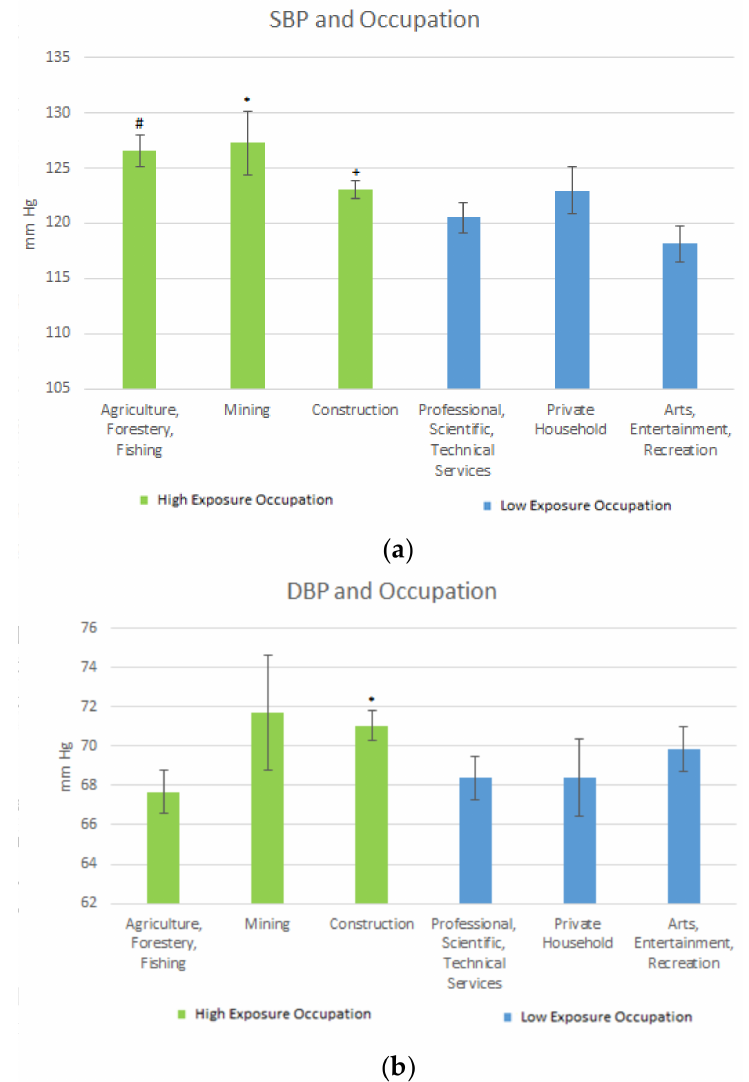
Figure 3. ( a ) Occupation and SBP Mean Levels. # Significant difference between Agriculture, forestry, fishing and Professional, Technical Services and Arts, Entertainment, Recreation; * Significant difference between mining and Arts, Entertainment, Recreation. Moderately for mining and Professional, Technical Service; + Significant difference between construction and Arts, Entertainment, Recreation. ( b ) Occupation and DBP Levels. * Significant difference between construction and Professional, Scientific and Technical